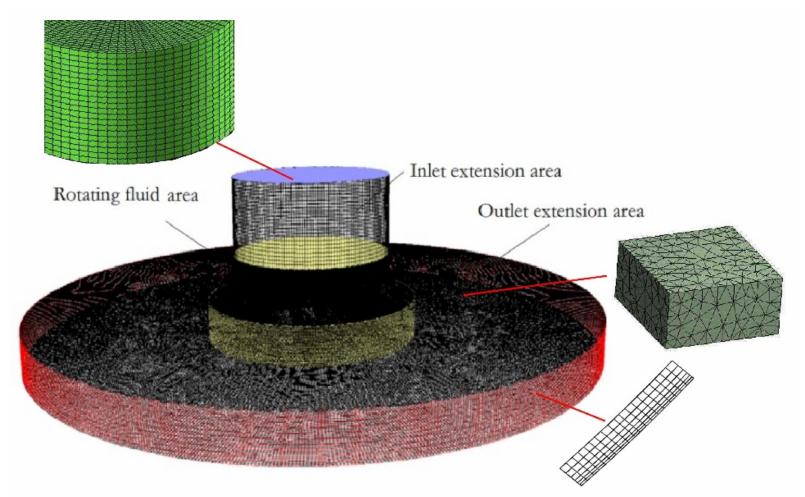
Figure 5. Flow field model and grid division of centrifugal